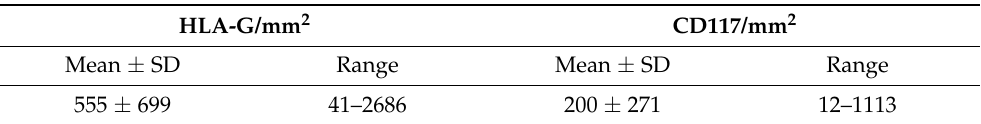
Table 1. Enumeration of HLA-G + and CD117 + cells/mm 2 in the livers of patients with alcoholic cirrhosis (N =